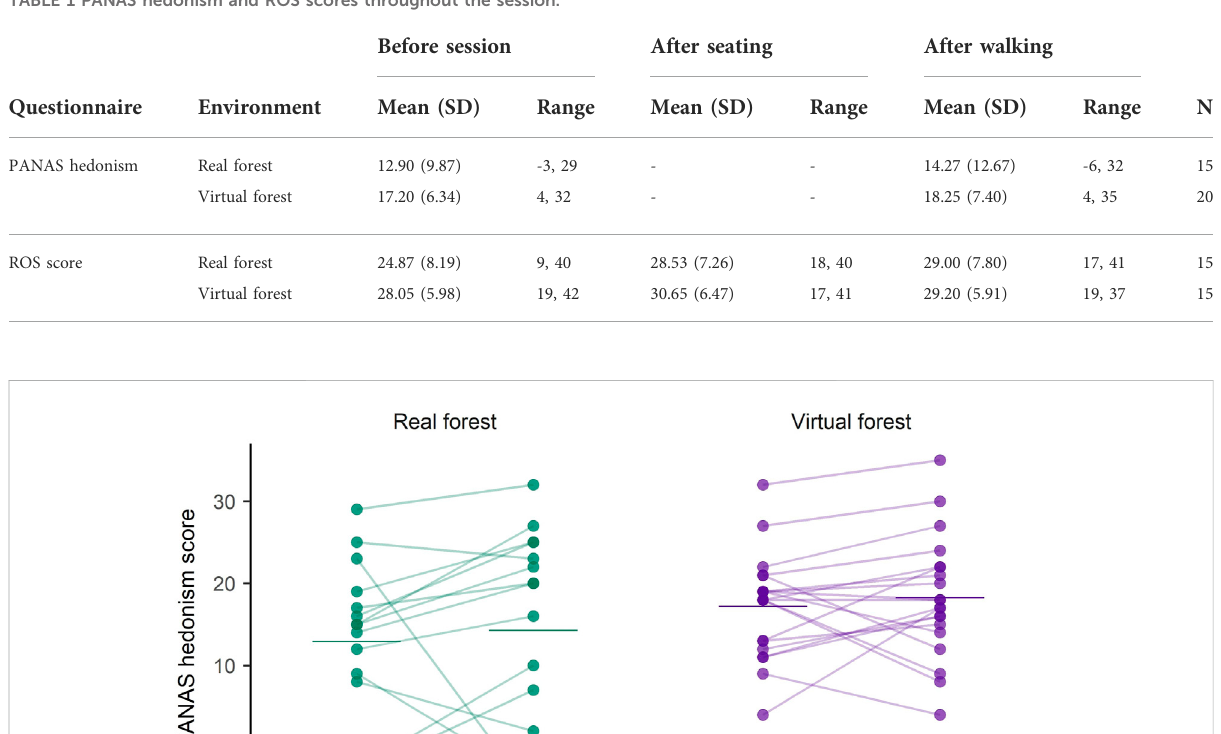
TABLE 1 PANAS hedonism and ROS scores throughout the session.